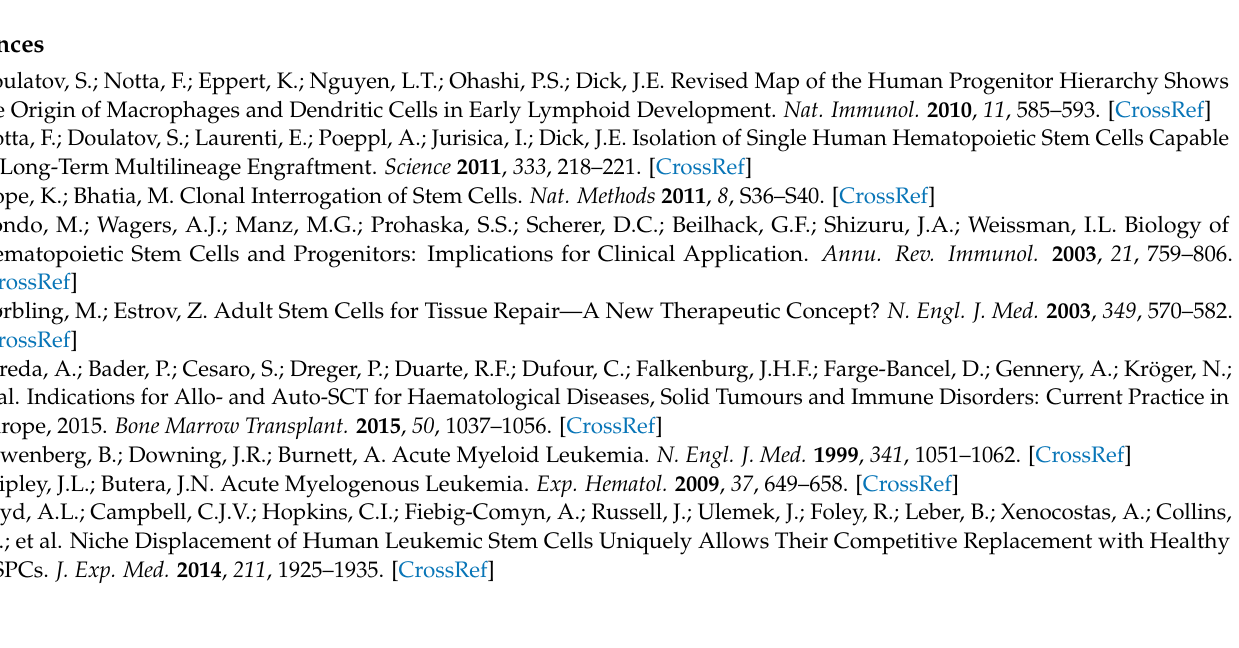
Figure S3. Molecular validation of 7TF induction. Figure S4. Data from transplantation